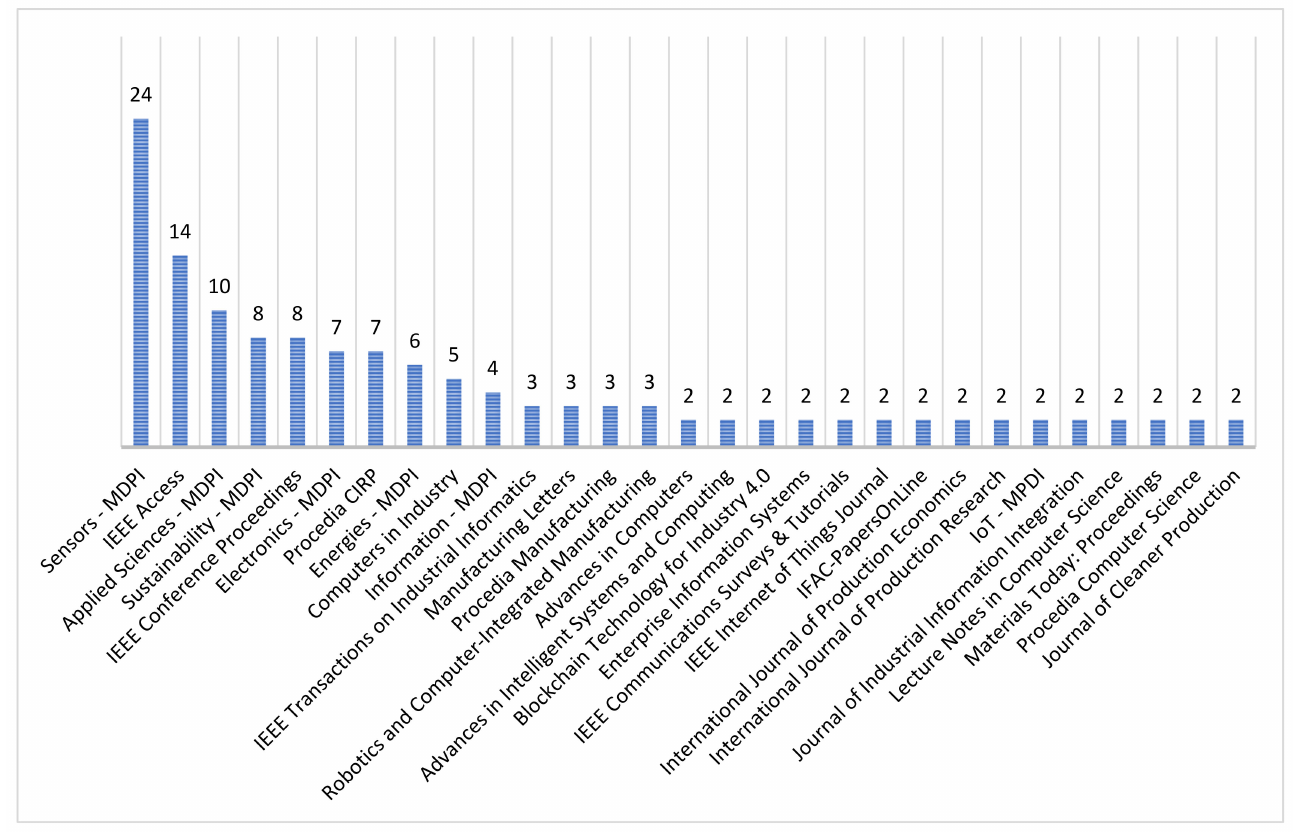
Figure 8. Leading journals in this work.